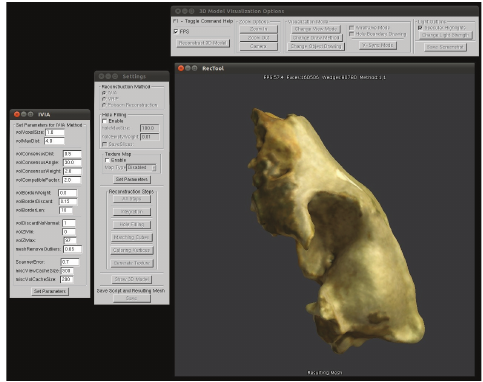
Fig. 1. Interface of the 3D reconstruction system. It has windows with options for the integration stage, model reconstruction and 3D model